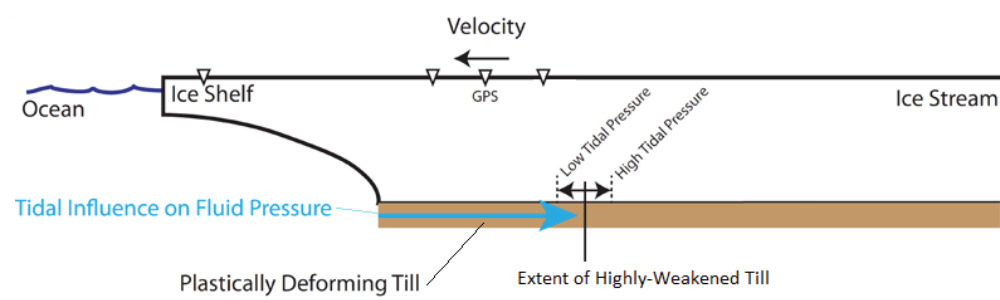
Figure 12. Schematic view of our hydrology hypothesis at neutral, high, and low tidal amplitudes, respectively. Triangles represent GPS stations on the surface of the ice stream and ice shelf. The brown layer represents subglacial till. Maximum extent of highly-weakened till is shown as a vertical line, and should vary in position with changes in the ocean tidal amplitude. When the maximum extent of highly- weakened till is farther inland, GPS stations move faster relative to a neutral position since more of the ice is streaming. Conversely, when the maximum extent of highly-weakened till is closer to the grounding line, the relative velocity of the GPS stations is lower than at a neutral